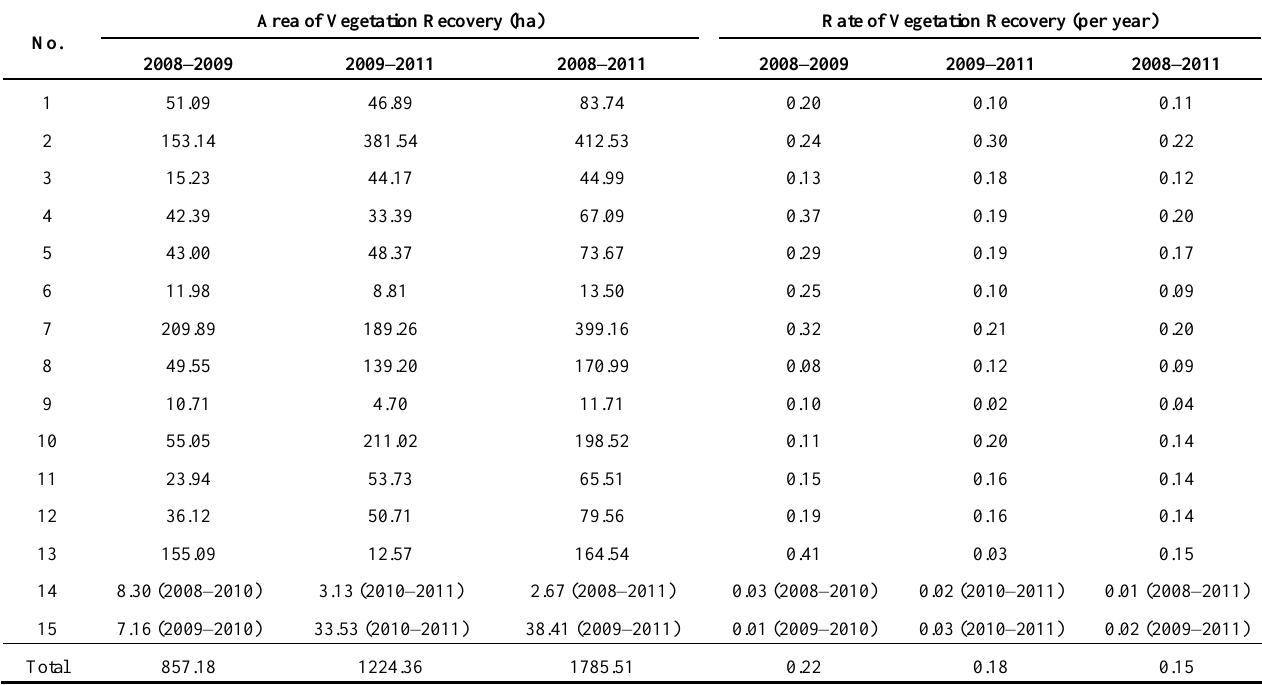
Table 5. Area and rate of vegetation recovery on previously bare landslide masses.